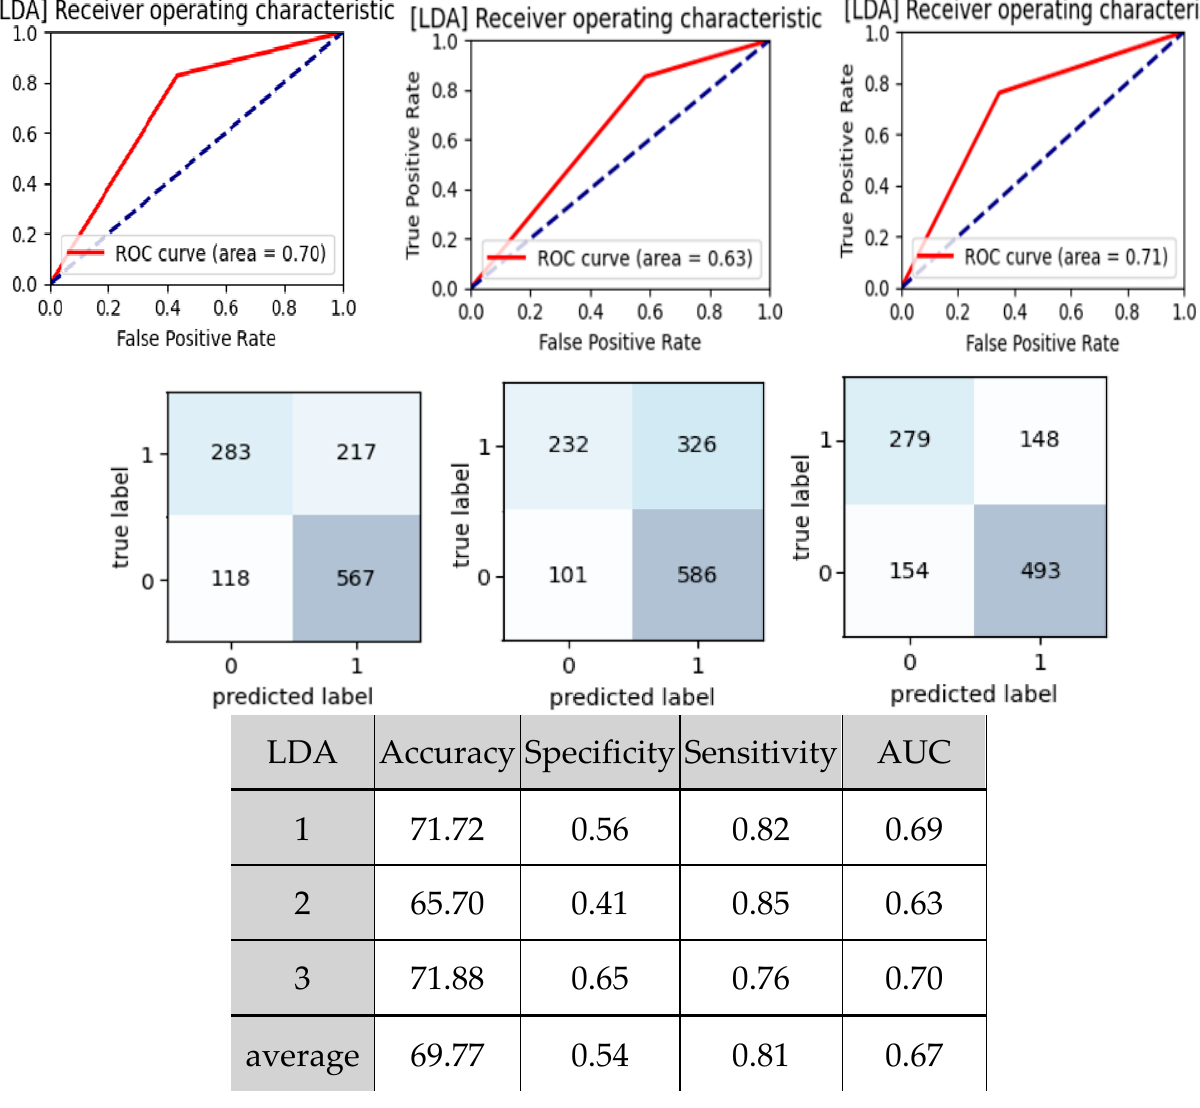
Figure 6. Results of ML analysis (LDA) of BPW indices for discrimination between Groups N and CV using pulse indices as features. “1” denotes cardiovascular side effects; “0” denotes no side effects. Table 3. Results of ML analysis (eight methods) for BPW indices in discriminating between Groups N and CV using pulse indices as features. Accuracies are presented as percentages. Threefold cross-validation values are listed. “*” denotes the highest average value. Among the eight methods, LDA had the highest accuracy and AUC (area under receiver operating characteristic